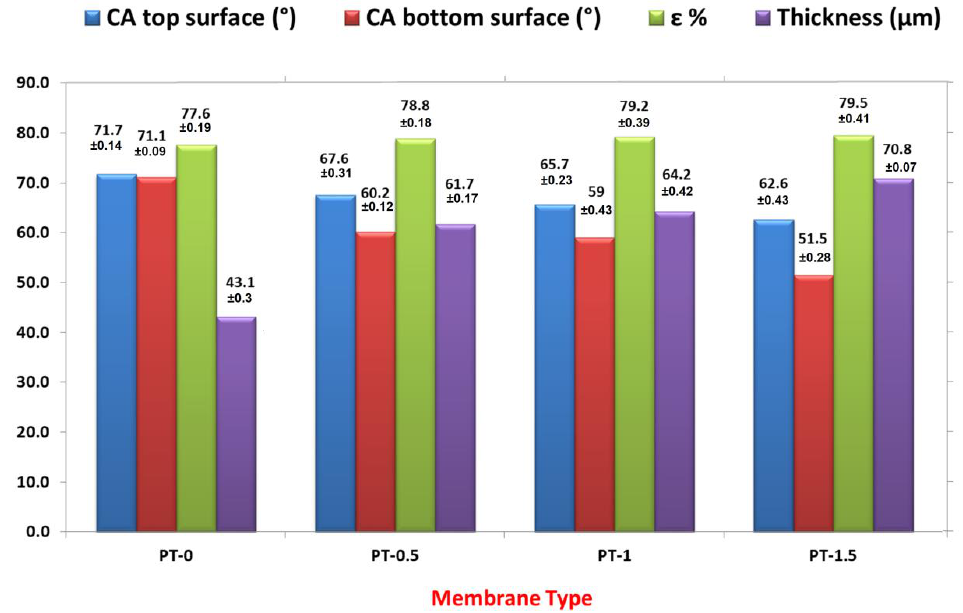
Figure 3. Contact angle (CA) (°), thickness (μm) and porosity (ε %) of the neat-PVC and PVC/TiO 2 NPs